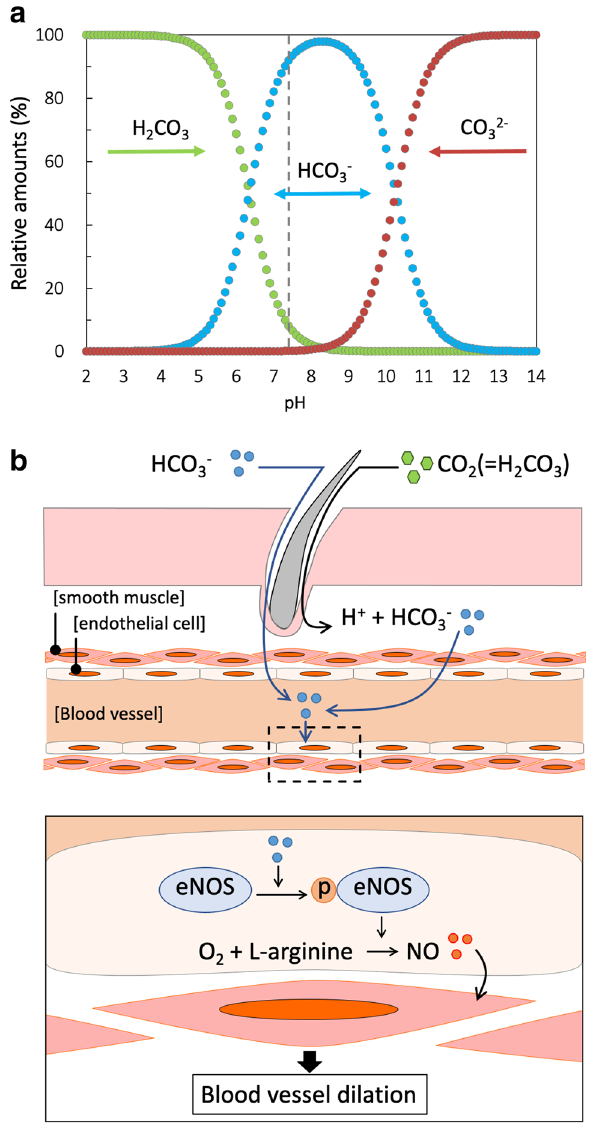
Figure 4. Schematic diagram of the underlying mechanism by which bicarbonate ions enhance blood flow. ( a ) Changes in the relative amounts of dissolved inorganic carbon (%) by pH. The pH of the neutral bicarbonate ion water (NBIW) was equivalent to that of blood, i.e., 7.4 (vertical dotted line). Among the dissolved inorganic carbon ions, bicarbonate ions (HCO 3− ) were most abundant. Modified from References 18 and 19. ( b ) Bicarbonate ions (HCO 3− ) and carbonic acid (H 2 CO 3 ) are absorbed percutaneously, and carbonic acid is changed into bicarbonate ions in vivo. Bicarbonate ions that enter endothelial cells phosphorylate endothelial nitric oxide synthase (eNOS). Phosphorylated eNOS produces nitric oxide (NO), which relaxes the smooth muscle in the outside of endothelial cells, resulting in dilation of the vessel. CO 32− carbonic ion, eNOS endothelial nitric oxide synthase, H + hydrogen ion, H 2 CO 3 carbonic acid, HCO 3− bicarbonate ion, NO nitric oxide, p-eNOS phosphorylated